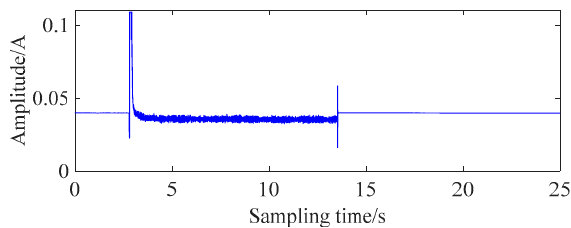
Figure 6. Signal of gear tooth-breaking(wear) fault.